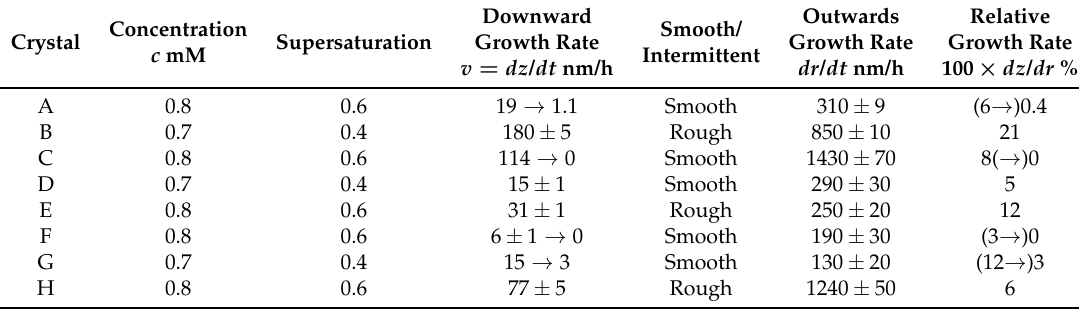
Table 1. Summary of growth rates for all the crystals. “Downward growth rate” is the growth rate in the confined region causing the crystal to be lifted upwards.